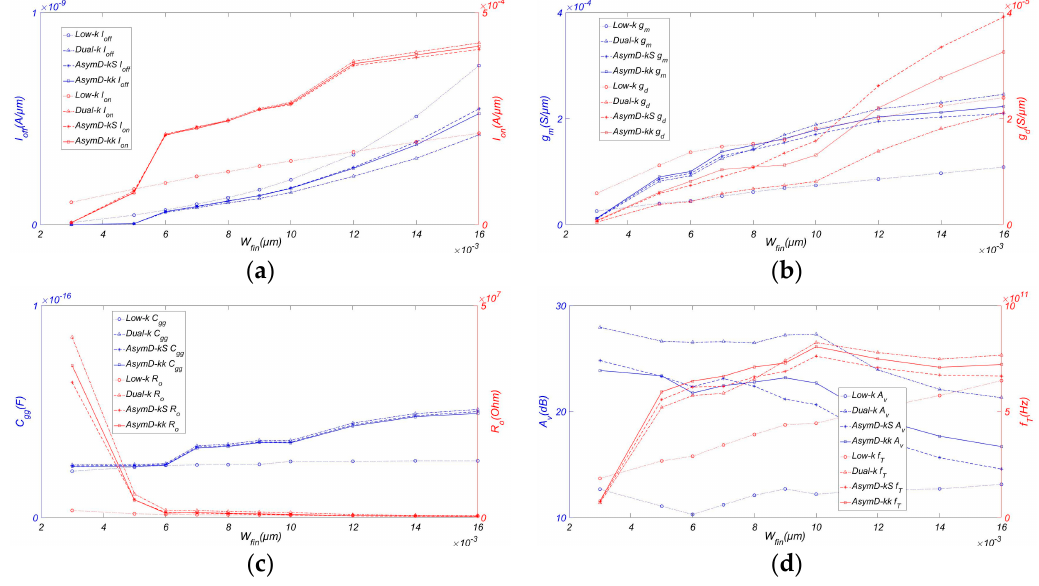
Figure 4. Variation of ( a ) I off and I on , ( b ) g m and g ds , ( c ) C gg and R o , ( d ) A v and f T of FinFET with AR. Simulated with H fin = 20 nm, L ext = 20nm, T ox = 0.8 nm, L hk = 12 nm, σ L = 3 nm, and V ds = 0.9 V.